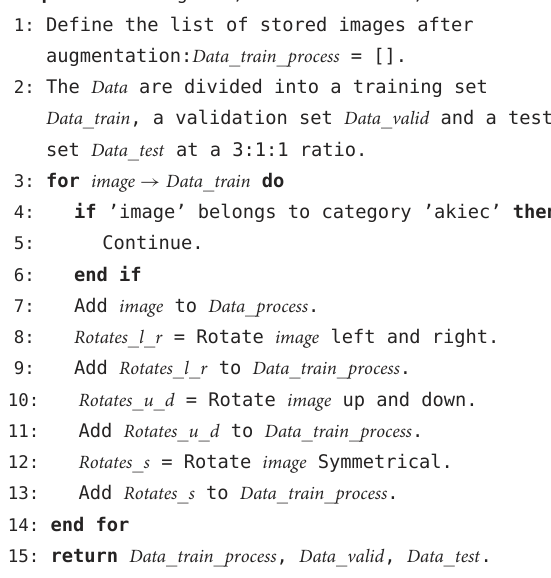
Algorithm 1. Image